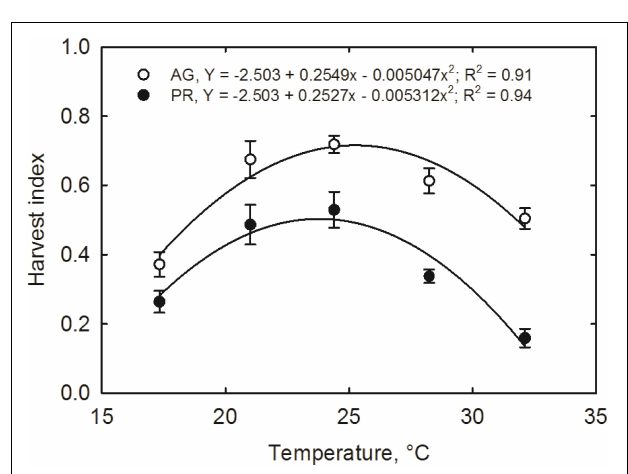
FIGURE 5 | Temperature effects on the harvest index of soybean cultivars, AG with indeterminate, and PR with determinate growth habits, respectively. Measurements were taken at 120 days after sowing and 82 days after temperature treatment. SEM ± 12 observations are presented if the values are larger than the symbol